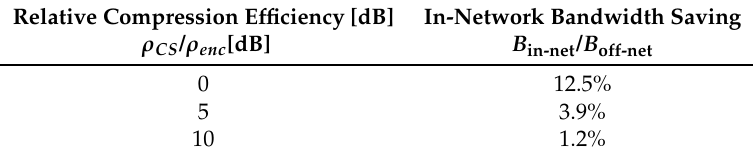
Table 2. In-network bandwidth savings versus CS to video codec relative compression